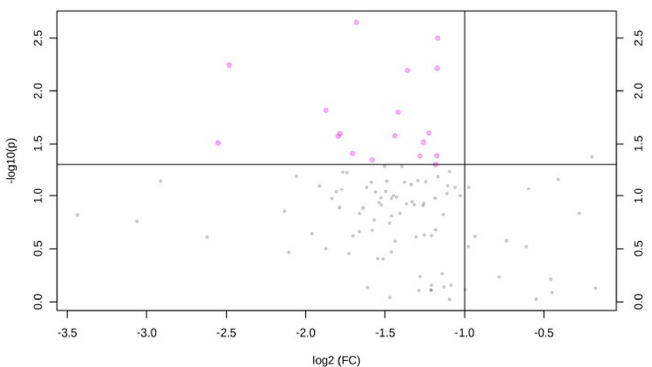
Figure 2. Comparison of lipid species across categories of diet. Volcano plot of important lipid features identified by the comparison between poor and intermediate dietary categories. This plot shows the magnitude (log 2 Fold-change of intermediate versus poor category; x -axis) and significance (−log 10 p -value; y-axis) for the comparison of lipids between intermediate and poor scores of dietary CVH metric. Lipid species with fold-change >2 or <0.5 and p -value < 0.05 are represented as pink dots. Table 1. Important lipid features selected, fold changes (FCs) and p -values. Lipid Species Fold-Change p -Value